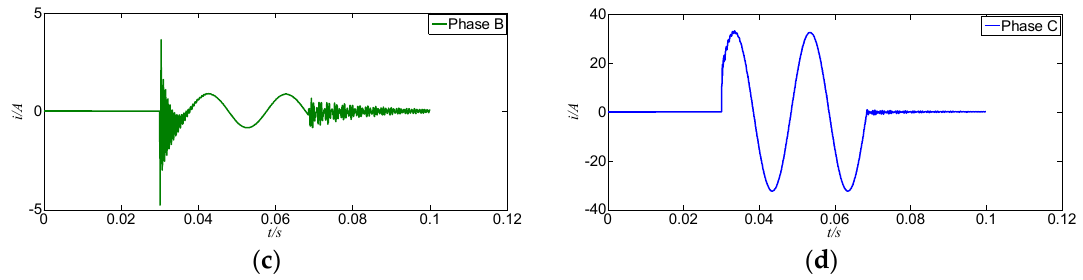
Figure 2. ( a ) Three-phase currents of a single-phase A grounded fault; ( b ) Fault component of phase A ; ( c ) Fault component of phase B ; ( d ) Fault component of phase C .